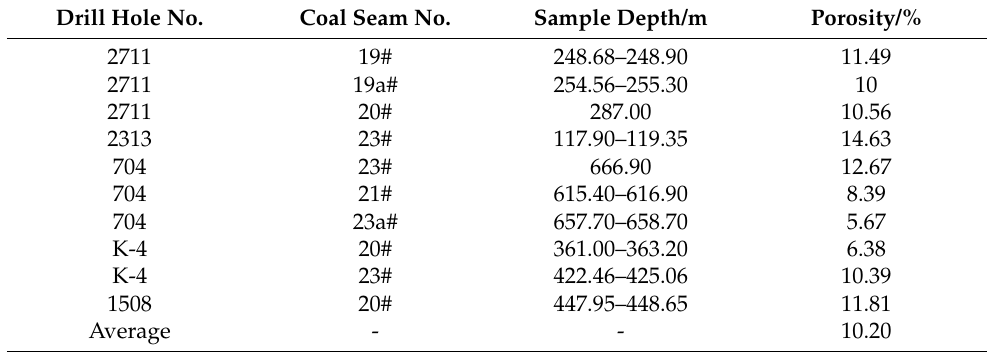
Table 2. Fracture porosities of coal samples drilled at different depths in the Hunchun coalfield. Drill Hole No. Coal Seam No.